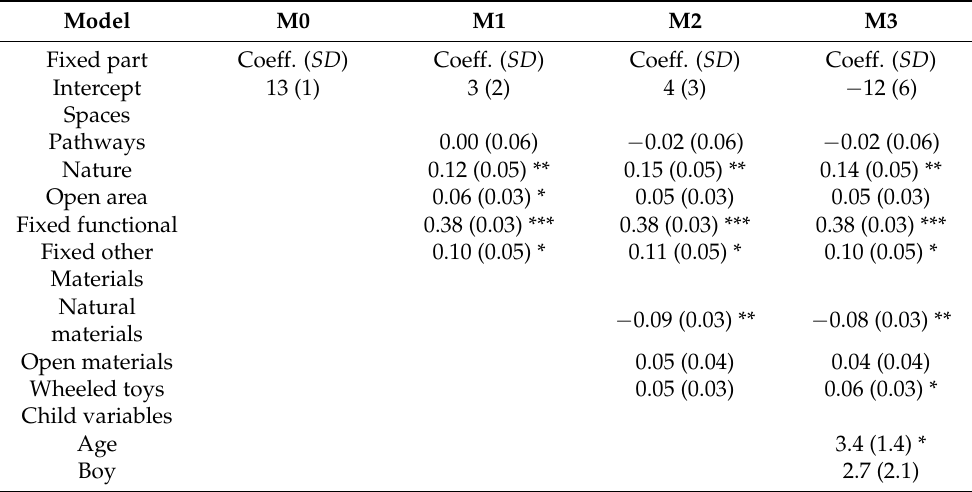
Table 2. Regression models for risky play ( n = 935